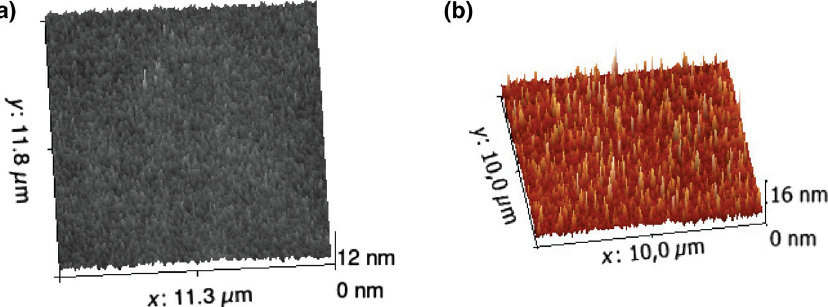
FIG. 5. AFM image of (a) the gold substrate (rms roughness ≈ 0 . 9 nm) and (b) the gold-coated sphere (rms roughness ≈ 1 . 5 nm). For the sphere, the spherical background of the raw AFM image is